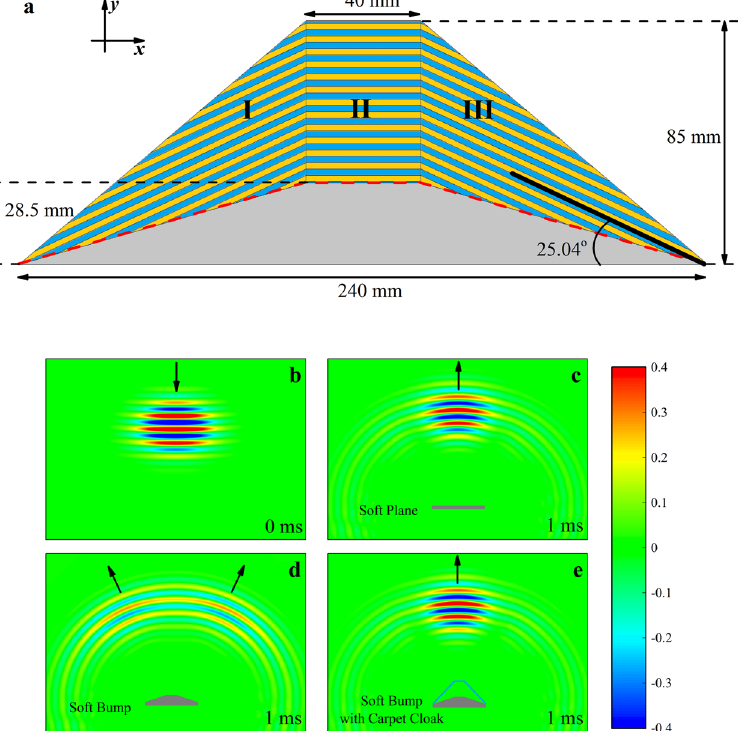
Figure 2. Numerical simulations of the underwater carpet cloak. ( a ) Schematic view of the ideal carpet cloak. Each region of the carpet cloak is a multilayered structure which is made up of two different materials (blue and yellow layers) with the same thickness. ( b ) The incident acoustic field when a Gaussian pulse signal is emitted from the top boundary. The background fluid is water. ( c – e ) The scattered acoustic fields. The acoustic wave is reflected by ( c ) a soft plane, ( d ) a soft bump and ( e ) a soft bump with the carpet cloak, respectively. Black arrows represent the propagation of the